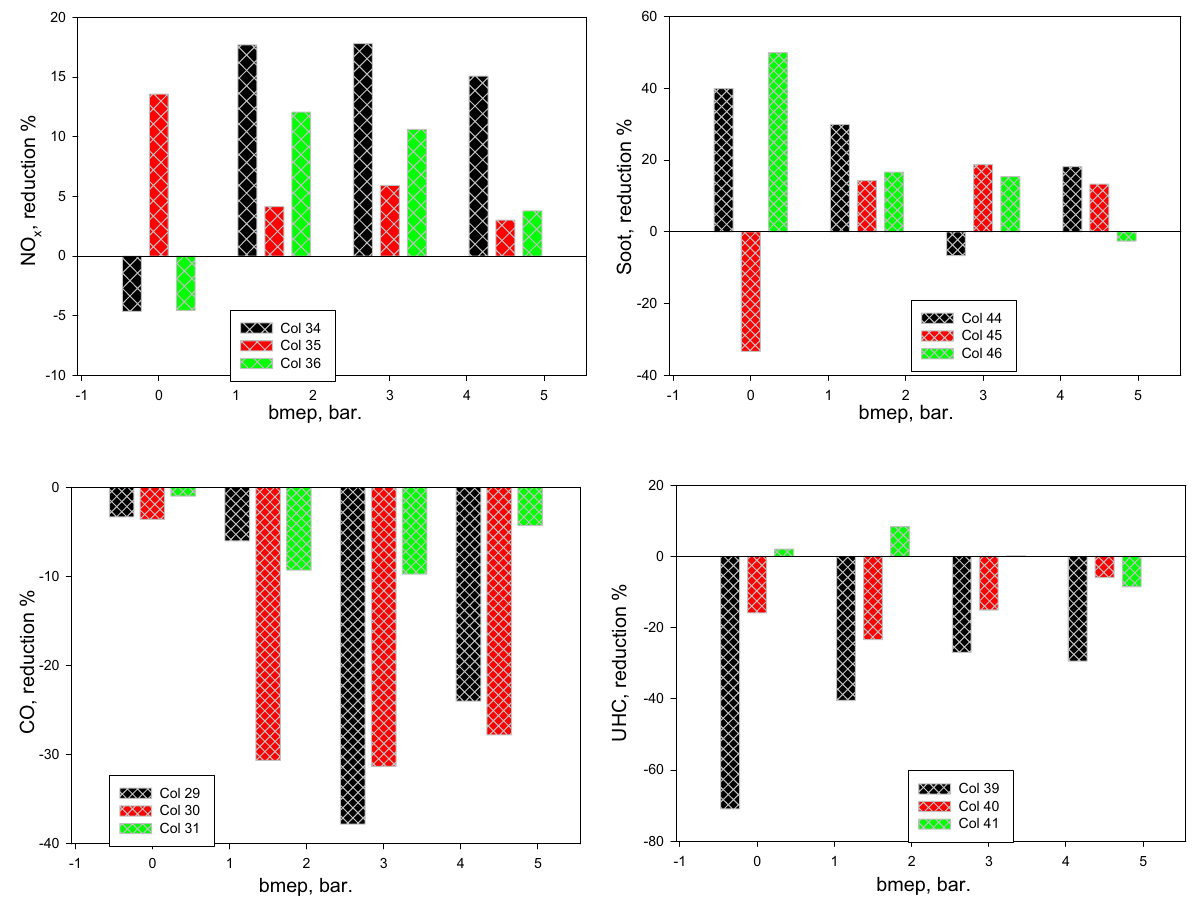
Figure 10. Reduction percentage of the NO x , soot, CO, and UHC levels with bmep for tested fuels.